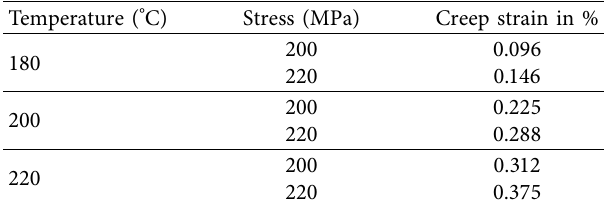
Table 2: Creep strain with a variety of aging temperature and stress values.